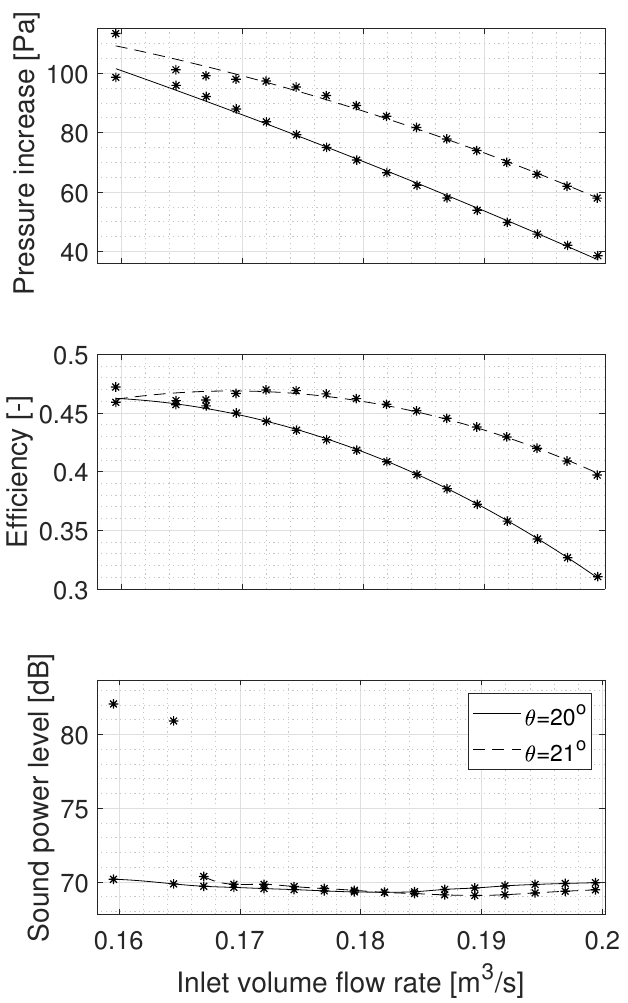
Figure 12. Pressure increase, efficiency, and sound power level characteristics for blade angles 20 ◦ and 21 ◦